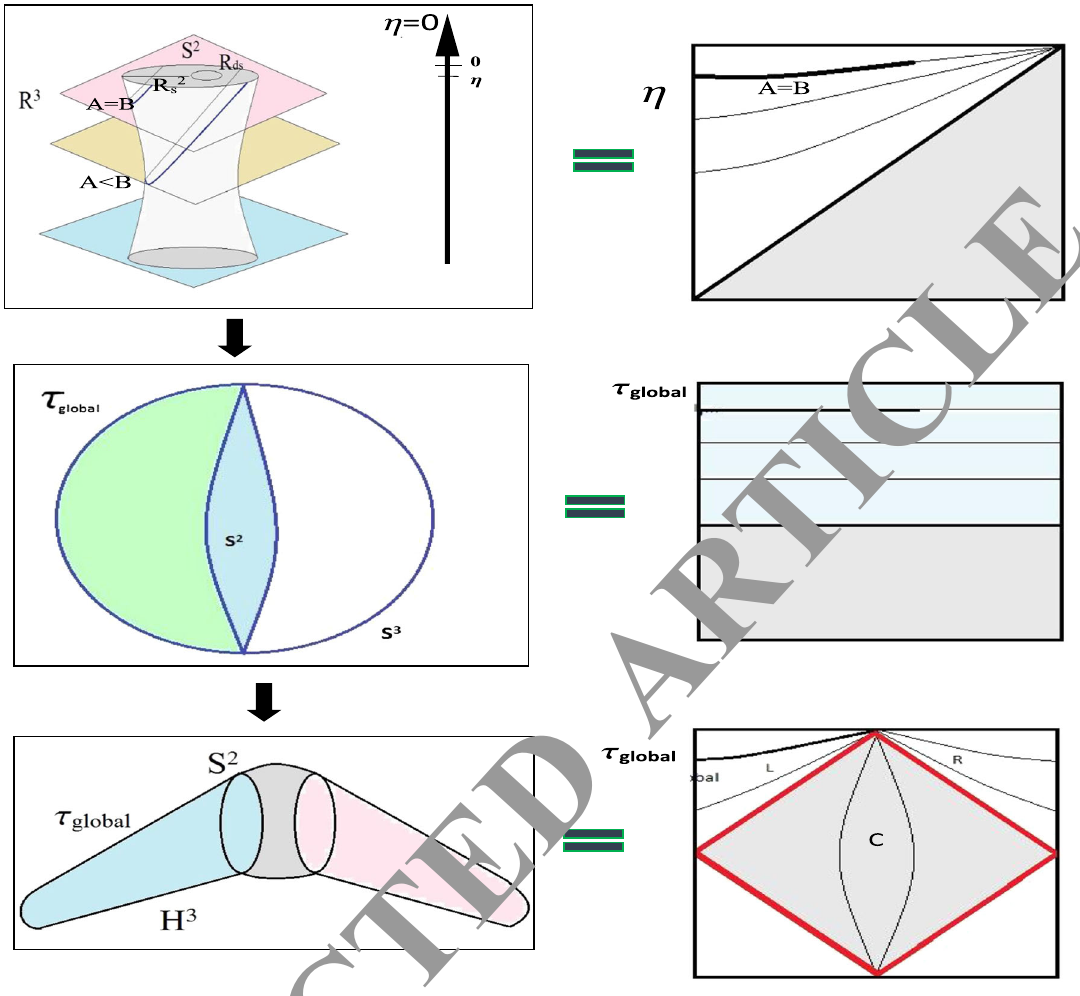
Fig. 2 Schematic diagram for the geometrical construction and underlying symmetries of the bipartite quantum field theoretic system of de Sitter hyperbolic open chart. Corresponding Penrose diagrams are also drawn for completeness